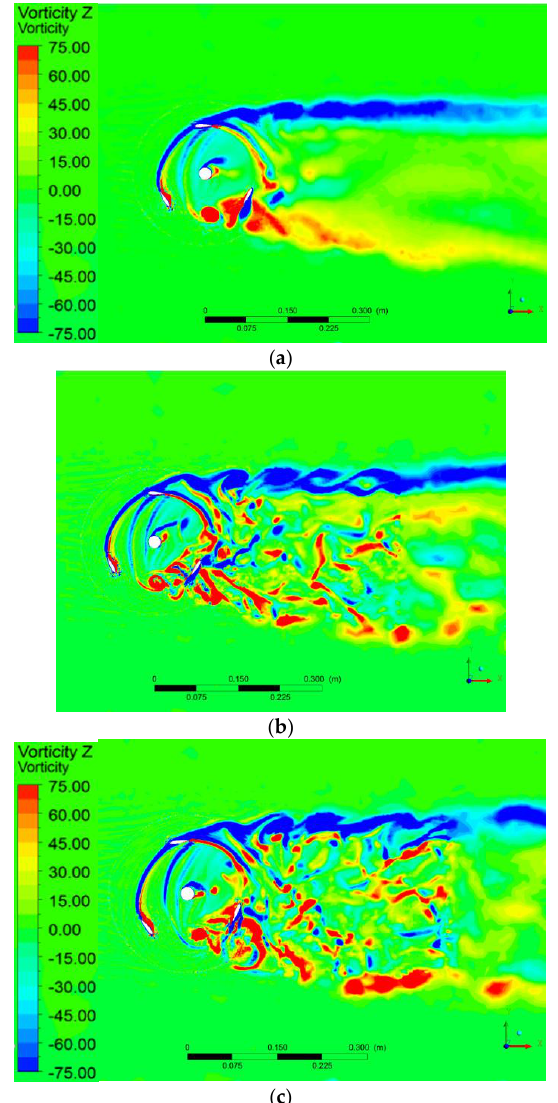
Figure 14. Instantaneous vorticity field on the symmetry plane for the ( a ) URANS, ( b ) DES and ( c ) DDES models, at λ = 2.